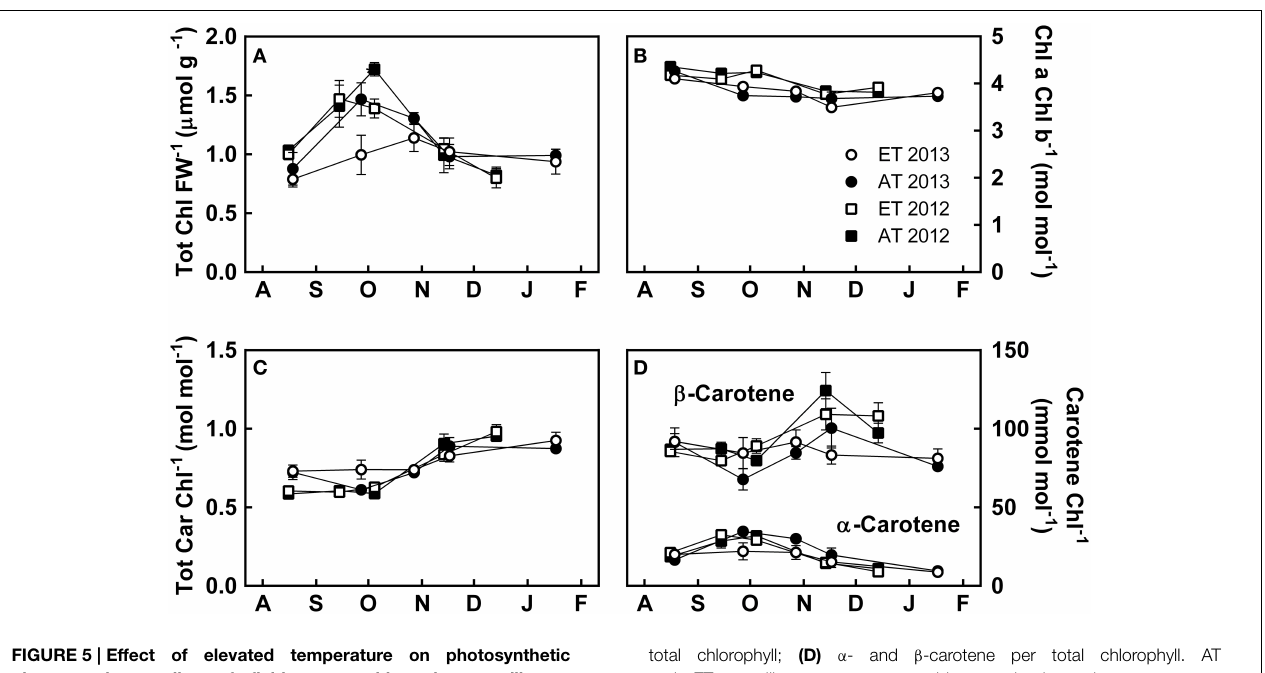
total chlorophyll; (D) α - and β -carotene per total chlorophyll. AT and ET, seedlings grown at ambient and elevated temperature, respectively. Each data point represents the average of 5 plots, ±